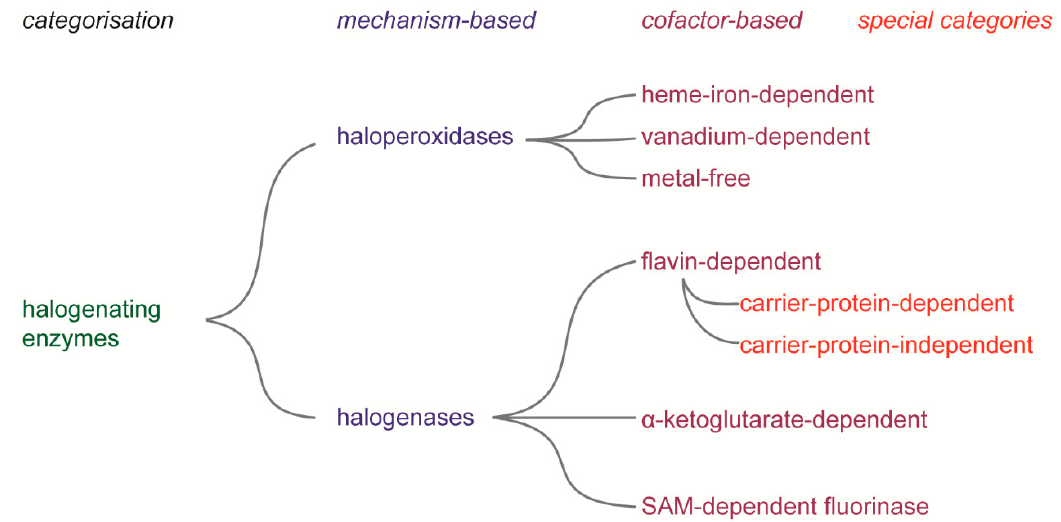
Figure 6. Overview on the categorization of halogenating